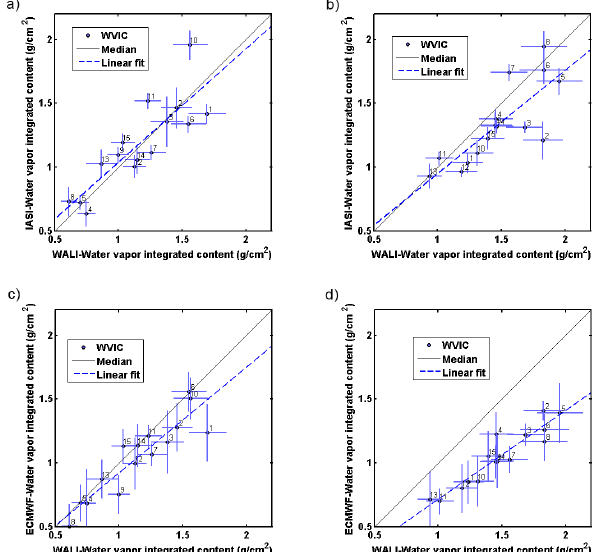
Figure 5. Water vapor integrated content (WVIC in gcm − 2 ) as measured by WALI lidar against IASI WVIC retrieval for HyMeX (a) and ChArMEx (b) periods and against ECMWF WVIC for HyMeX (c) and ChArMEx periods (d) . Line styles are given in each individual figure legend.